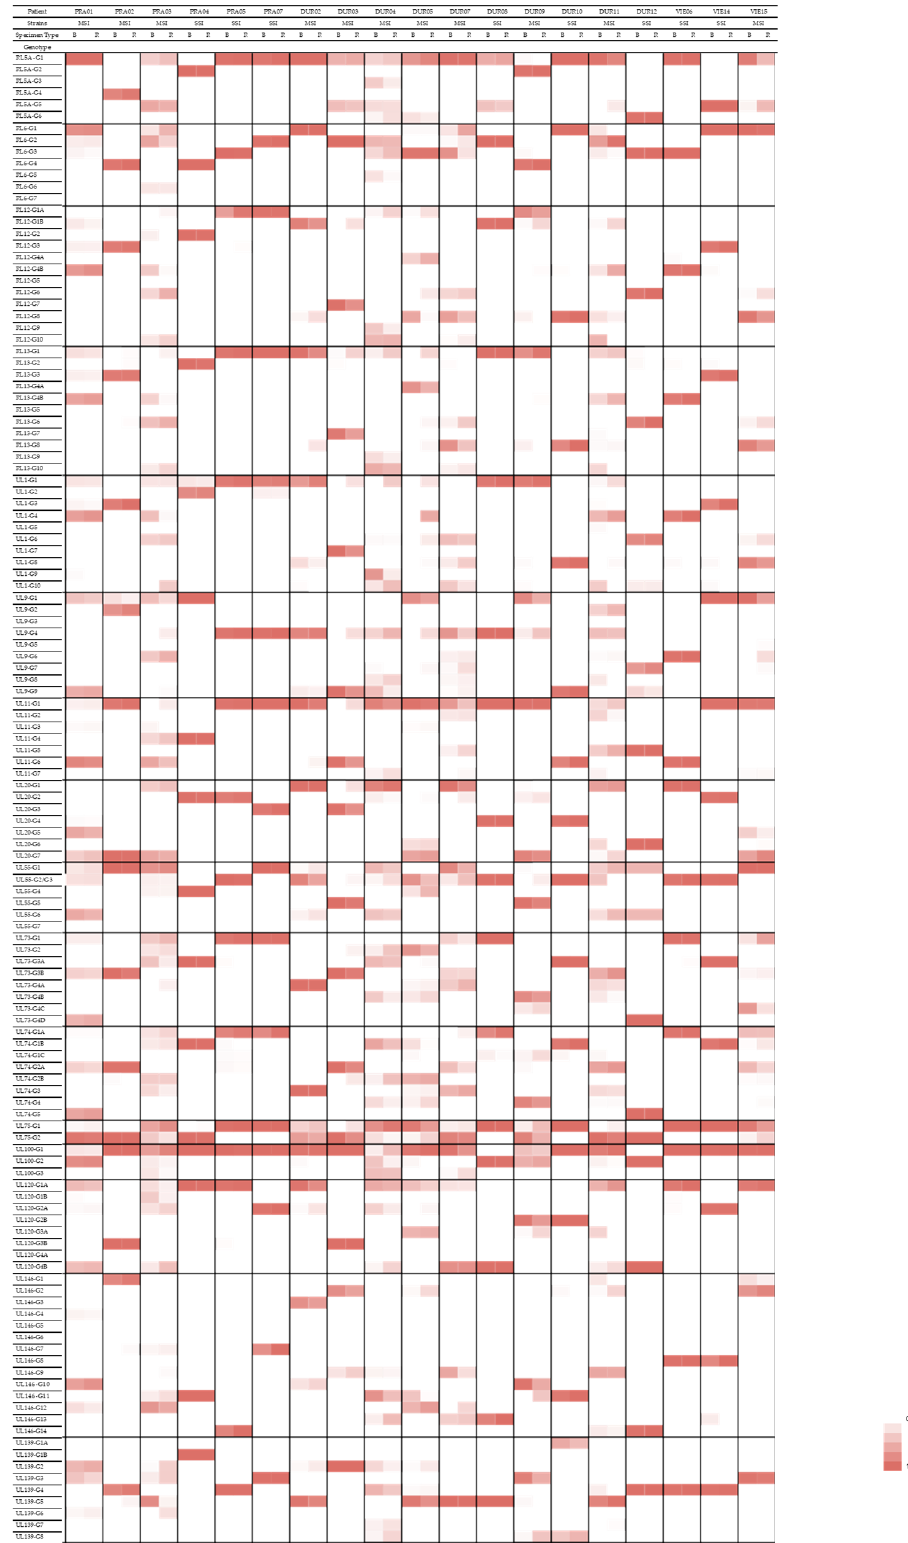
Figure 1. Heatmap showing distribution of genotypes between respiratory and blood specimens. The frequencies of reads are depicted for genotypes in respiratory and blood specimens of eleven patients with multiple-strain infection on a color scale, with darker shading in increments of 20%. MSI = multiple-strain infection. SSI = single-strain infection, B = blood; R =